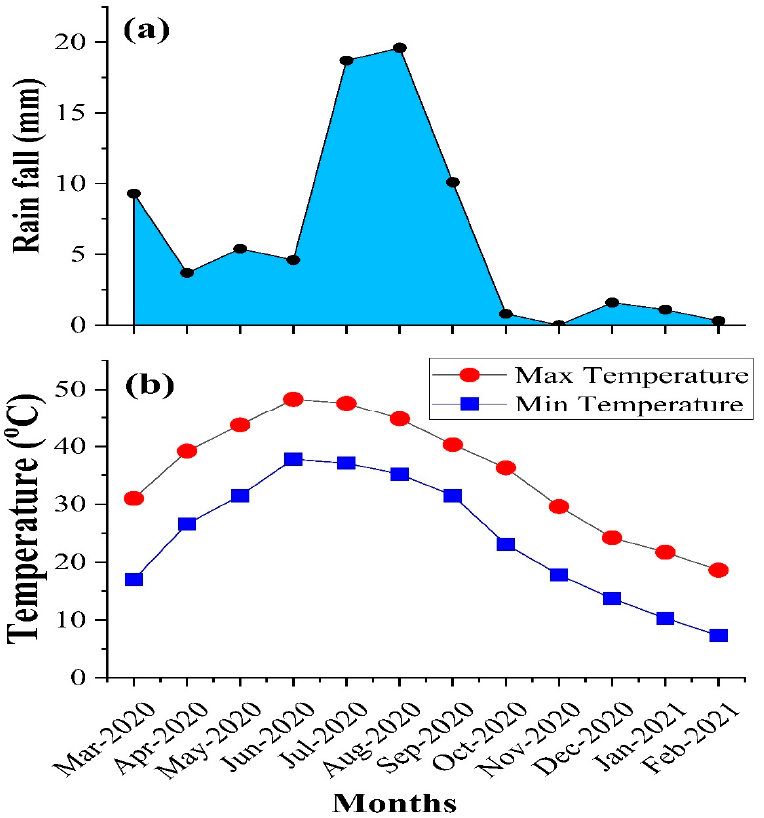
Figure 1. Weather data of the sampling year. ( a ): average monthly rainfall; ( b ): average monthly temperature.